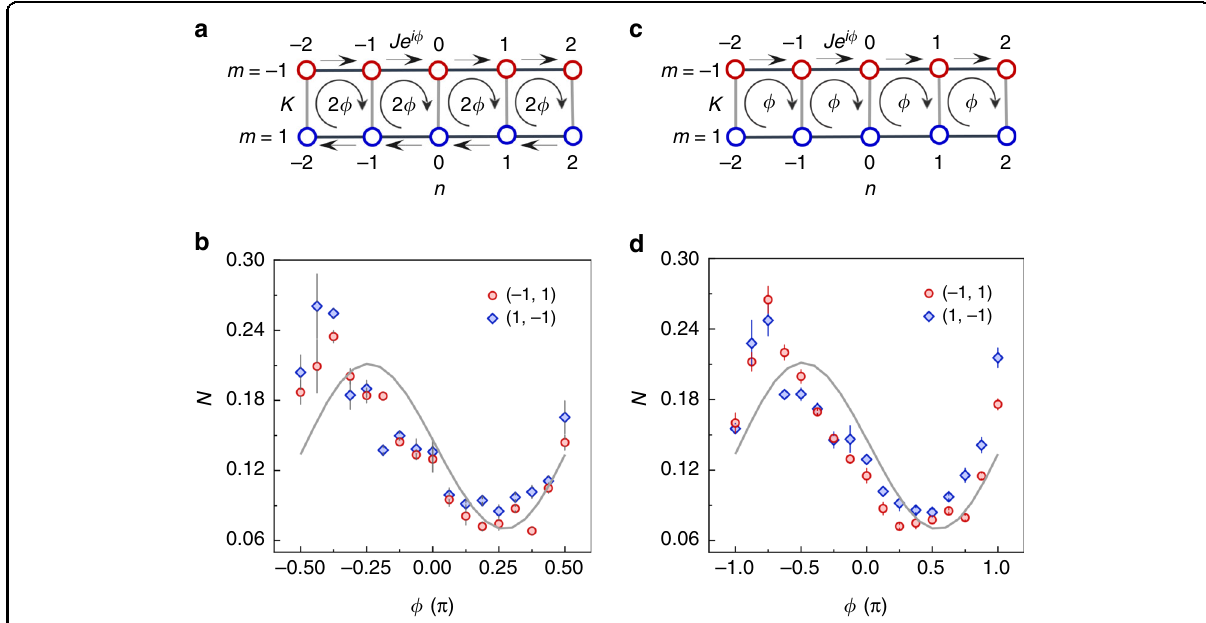
Fig. 3 Dependence of atomic population on the gauge phase in a two-leg ladder. a Schematic of a two-leg ladder with a gauge fl ux Φ = 2 ϕ in each plaquette. b The initial sate is prepared in an equal superposition of two momentum-state sites ( − 1, 0) and (1, 0). The populations on the sites ( − 1, 1) and (1, − 1) are measured after a duration of t = 160 µ s as a function of gauge phase ϕ . c shows the synthetic gauge fl ux Φ ¼ ϕ when the tunneling phases in the leg m = 1 are turned off. d The populations on the sites ( − 1, 1) and (1, − 1) corresponding to the case in ( c ) after the same duration t . Solid lines in ( b ), ( d ) represent the results from the numeric simulation of noninteracting tight-binding models. The intra- and inter-leg coupling energies are set as J/ ћ = 2 π × 500 Hz and K/ ћ = 2 π × 500 Hz, respectively